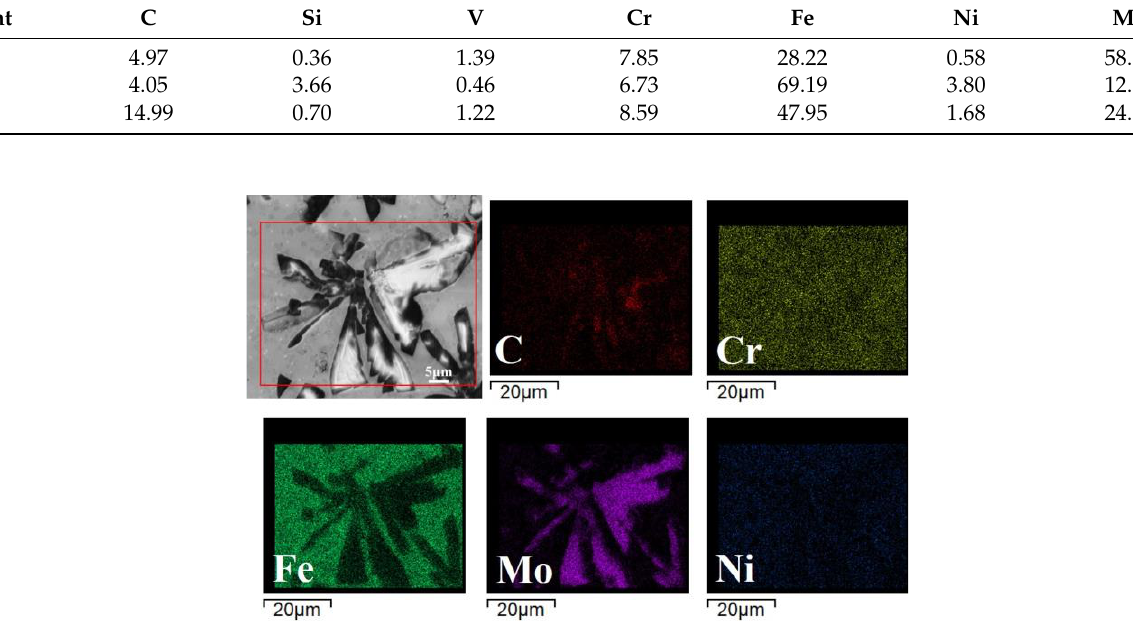
Figure 10. Mapping results of elements of S4 coating.